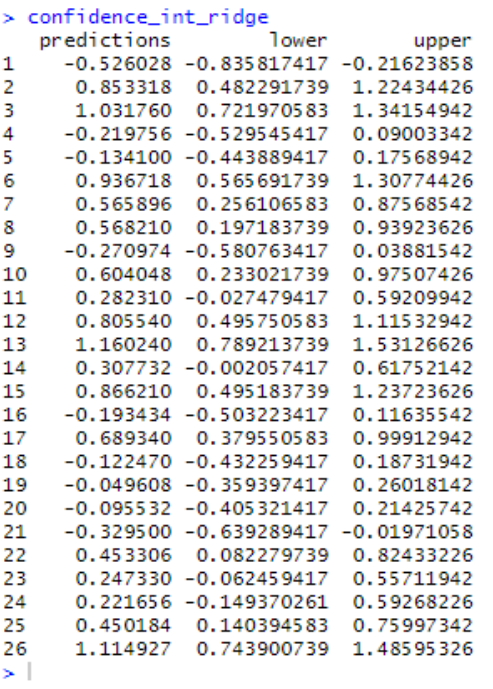
Figure 4. Confidence and prediction intervals for multiple linear regression predicted values